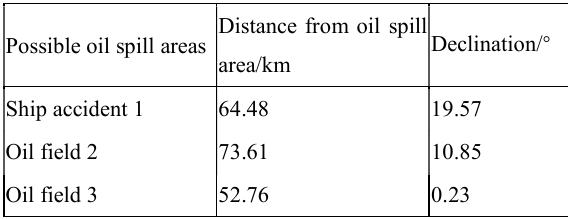
Table 3. Oil spill source determination of zone A